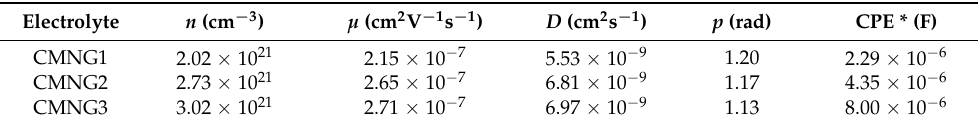
Table 2. The values of D , µ , and n at room